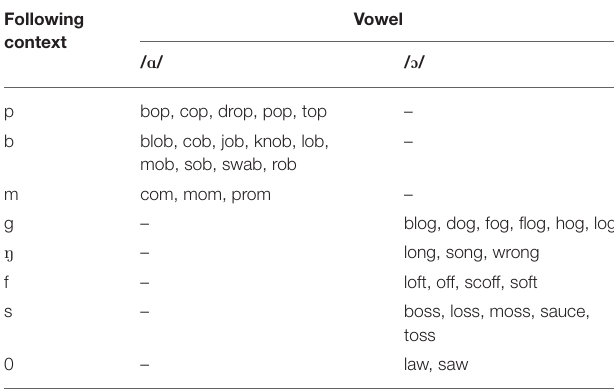
TABLE 2 | Contexts of phonological neutralization in varieties without complete